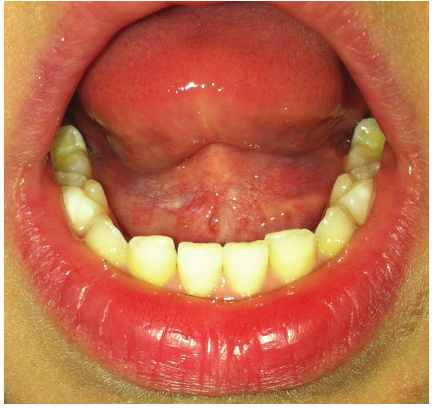
Figure 5: Clinical appearance 6 months after the